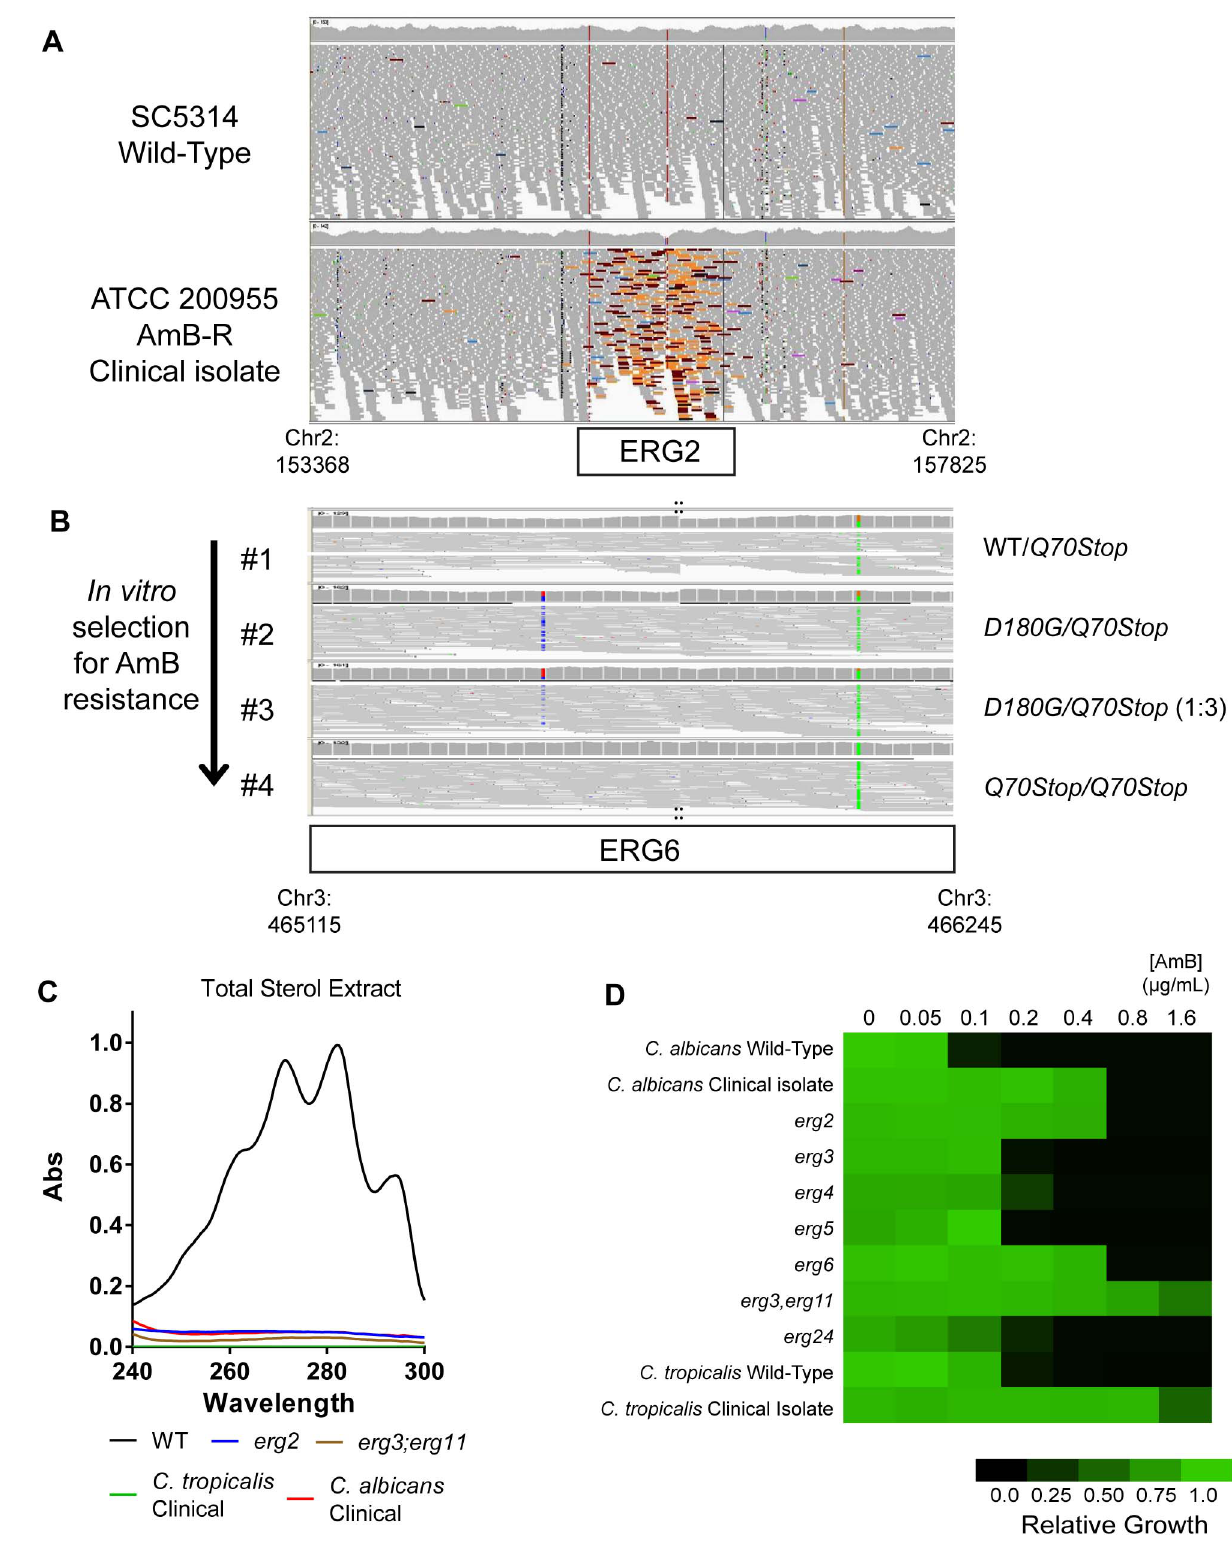
Figure 1. Mechanisms of AmB resistance in Candida . (A) Alignment of reads from whole-genome sequencing of C. albicans wild-type strain SC5314 and AmB-resistant clinical isolate ATCC 200955 demonstrates transposon insertion in ERG2 in the clinical isolate. The ERG2 locus is shown. Colored reads are indicative of mate-pairs that do not both map to the same chromosome, but instead one end to ERG2 and the other end to the TCA2 locus (elaborated in Figure S1A). Reads were visualized with the integrative genomics viewer (IGV) [53]. (B) Alignment of selected strains from whole-genome sequencing of in vitro –evolved AmB-resistant series identifies causal mutations. Mutations in ERG6 ORF are highlighted, and the